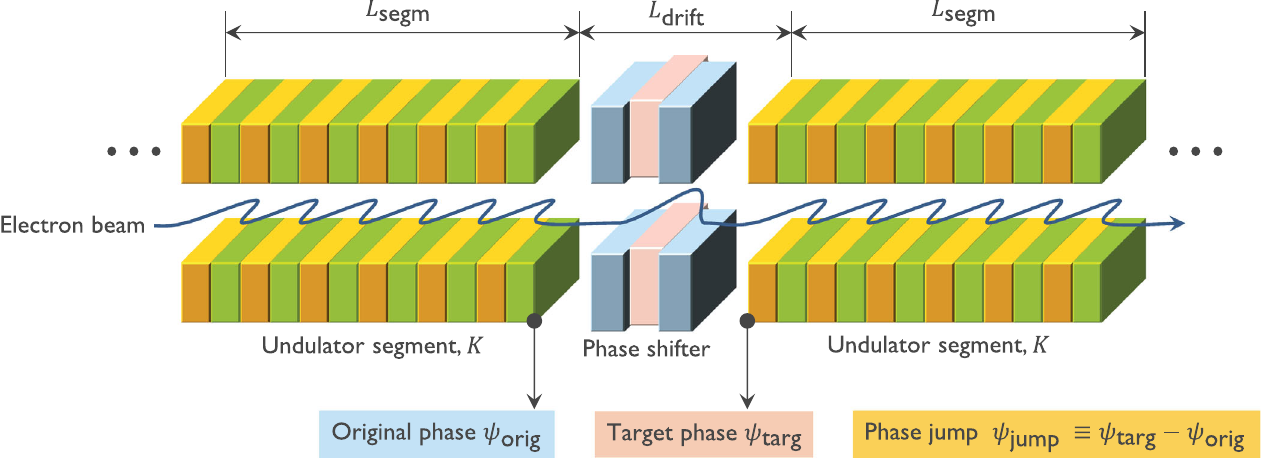
FIG. 1. Schematic diagram showing two of the undulator segments and the drift section in between. The phase shifter in the drift section can increase the electron path length, thus adjusting the phase angle between the electron beam and the optical wave. Focusing magnets, corrector magnets and diagnostics instruments are also commonly installed in drift sections, but are not shown in this